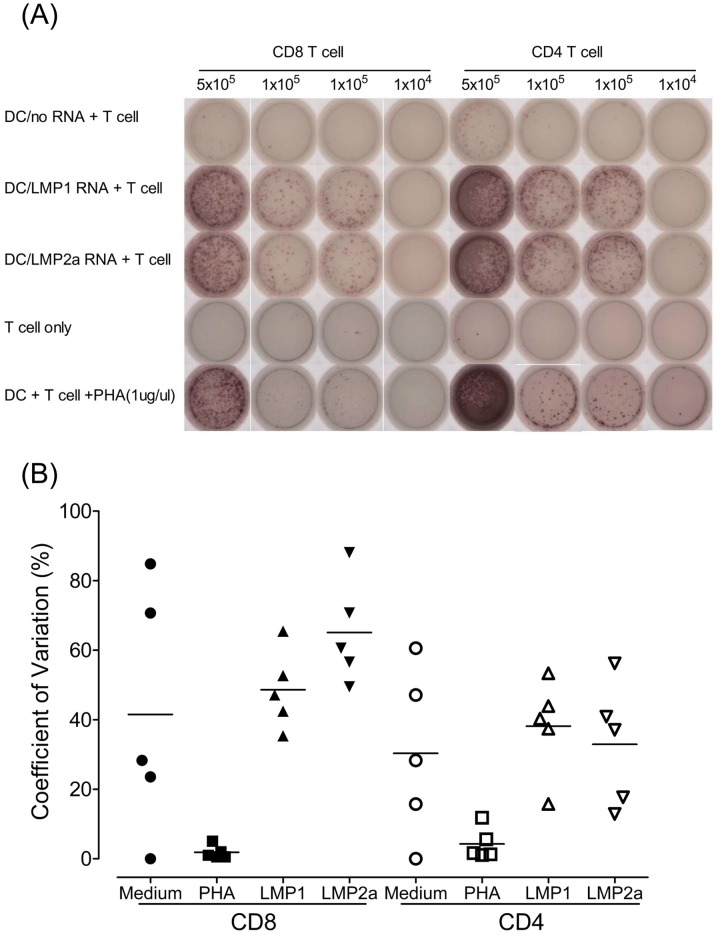
Measurement of immune responses to EBV antigen by IFN-γ ELISPOT assay in healthy donors.(A) Production of IFN-γ by CD8+ and CD4+ T cells against various stimulators such as DCs, LMP1- and LMP2a mRNA-transfected DCs, or phytohemagglutinin (PHA; 1 μg/μL). (B) Reproducibility of the ELISPOT assay. Inter-assay variations were evaluated in ELISPOT assays using CD8+ and CD4+ T cells from five EBV-seropositive healthy donors and LMP1 and LMP2a mRNA-transfected DCs, with PHA as the positive control. For the inter-assay variability, each symbol represents the mean of duplicate wells from each assay performed on two different days.